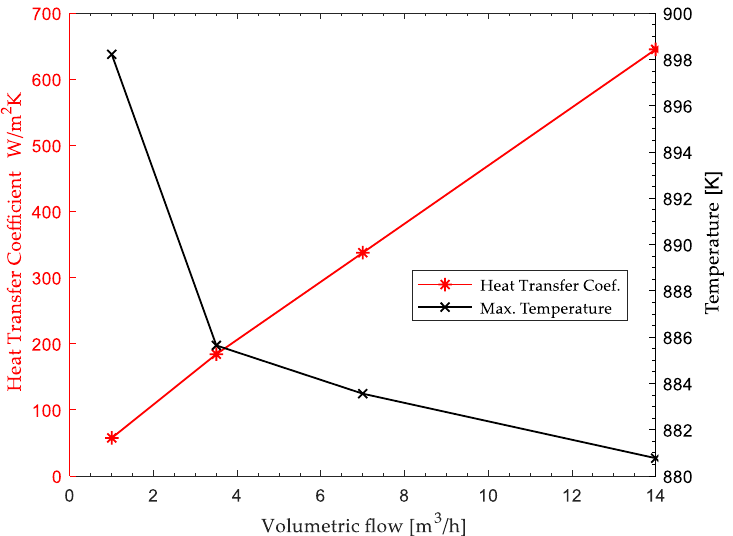
Figure 7. Average heat transfer coefficient at reactor tubes surface (1-m reactor module) and maximum hot spot temperatures for different Thermal oil feed rates.